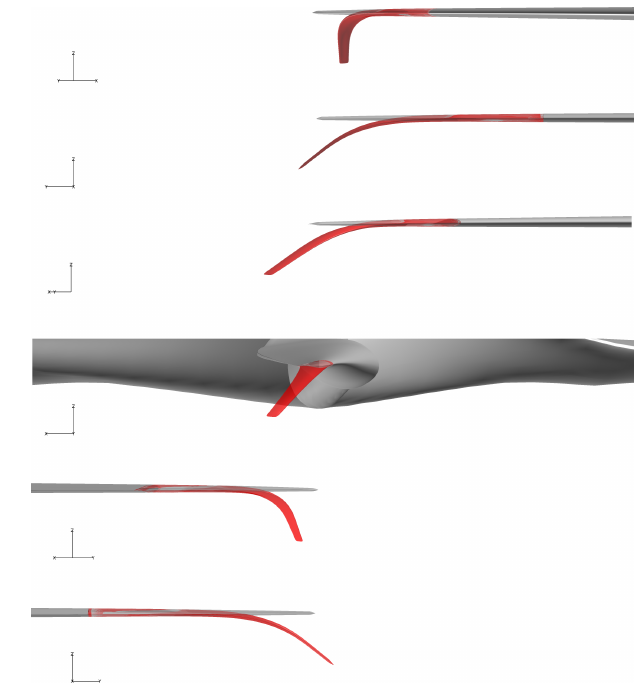
Figure A1. Baseline (gray) and optimized (red) blade shape from different